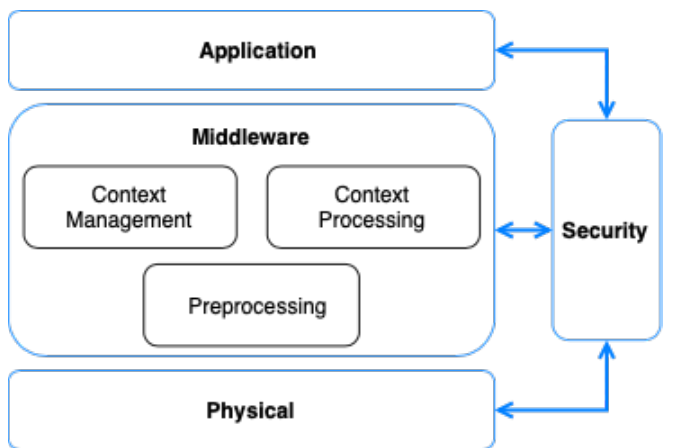
Figure 1. Abstract architecture for context-aware